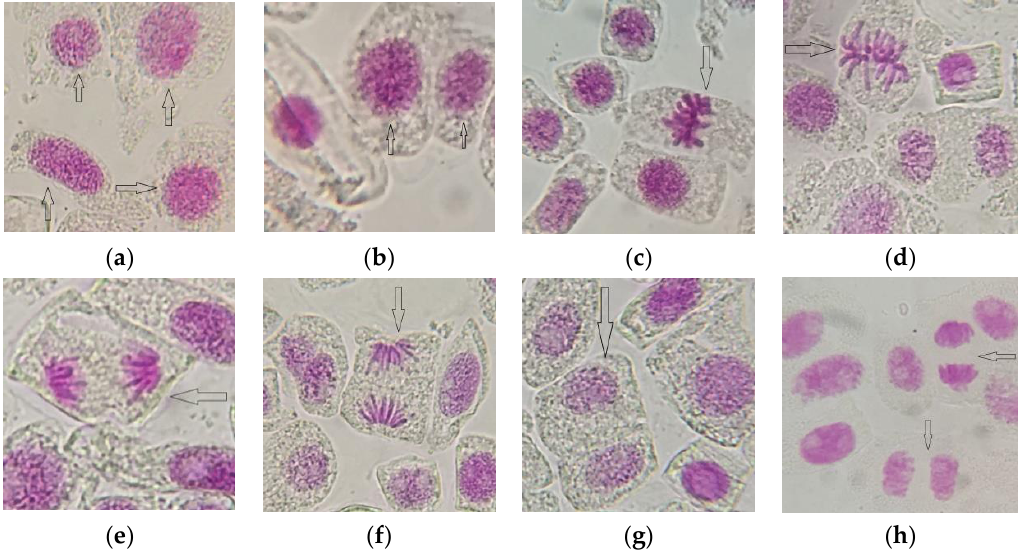
Figure 3. Aspects of mitotic activity on meristematic cells of A. cepa exposed to AESF treatment at 0.5 and 1.5% (1000× magnification): cells in prophase ( a , b ); cells in metaphase ( c , d ); cells in anaphase ( e , f ); cells in telophase ( g , h ).